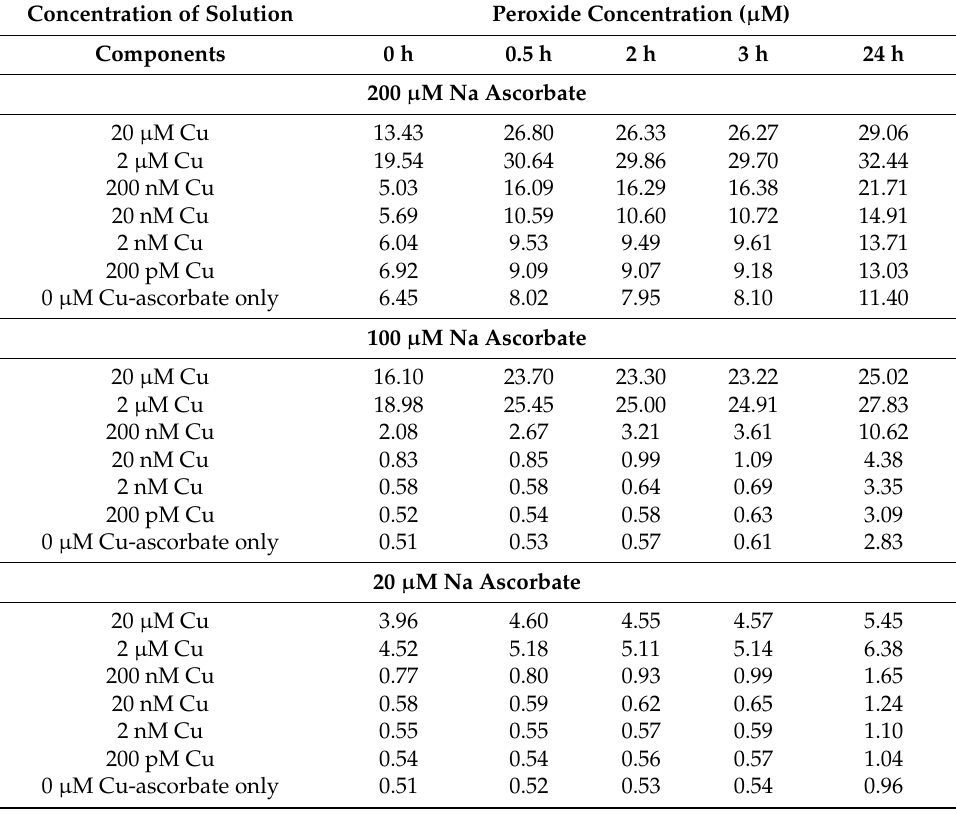
Table 2. Peroxide Production of copper (II) chloride in sodium ascorbate solution measured amplex red assay a